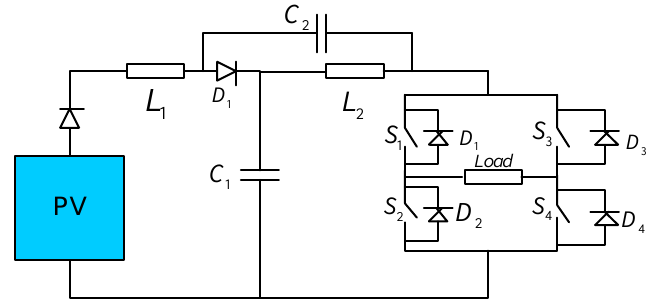
Figure 17. qZSMLI with PV power generation system.